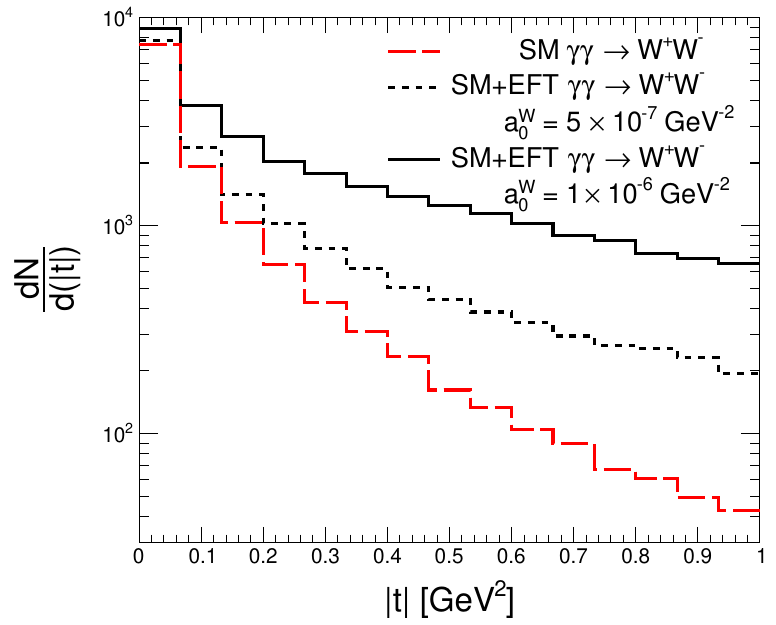
Figure 13 . Square of four-momentum transfer at the proton vertex, | t | , in pp → pW + W − p events at generator-level, for protons scattering towards positive or negative rapidities. The SM contri- bution is represented by the red histogram, while the SM and anomalous couplings distributions combined for coupling values of a W = 5 × 10 − 7 GeV − 2 and a W = 1 × 10 − 6 GeV − 2 are represented 0 0 by the solid and dashed black line, respectively. The distributions are normalized to cross section and